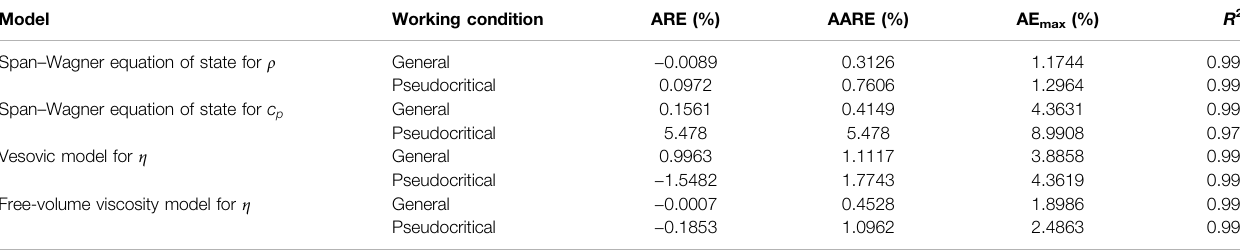
TABLE 4 | Comparison of the calculated values of each model with the experimental data. Model